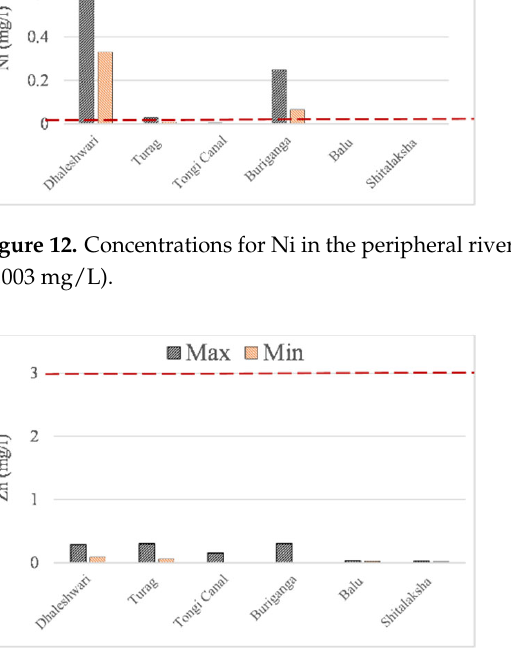
Figure 13. Concentrations for Zn in the peripheral rivers of Dhaka with WHO standard in dotted line (3 mg/L).